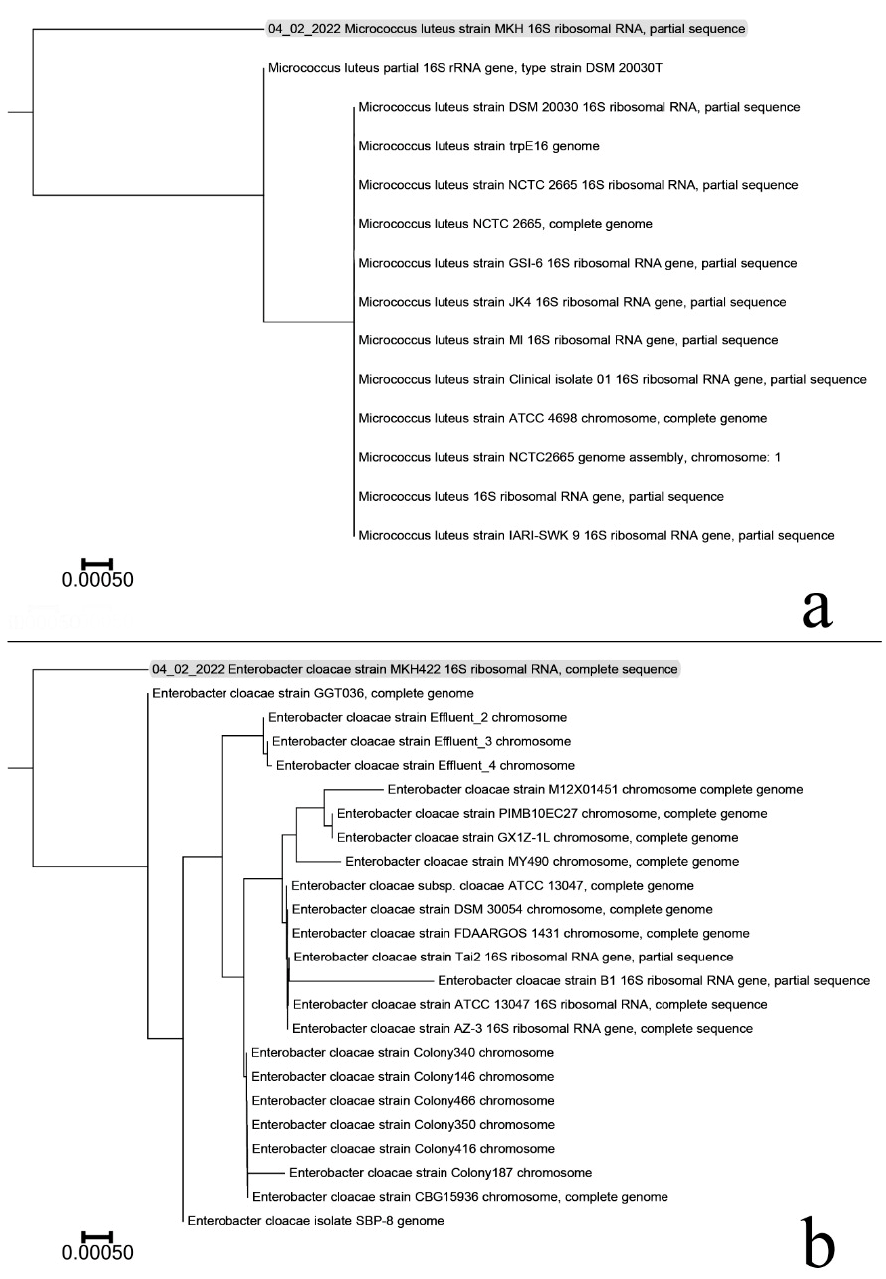
Figure 2. Based on 1000 replicates, the neighbor-joining tree of the 16S rDNA gene of the isolate Enterobacter cloacae (Accession no. OM519328) and 23 Enterobacter cloacae sequences ( a ). Micrococcus luteus (Accession number OM519327) and 13 Micrococcus luteus sequences ( b ).